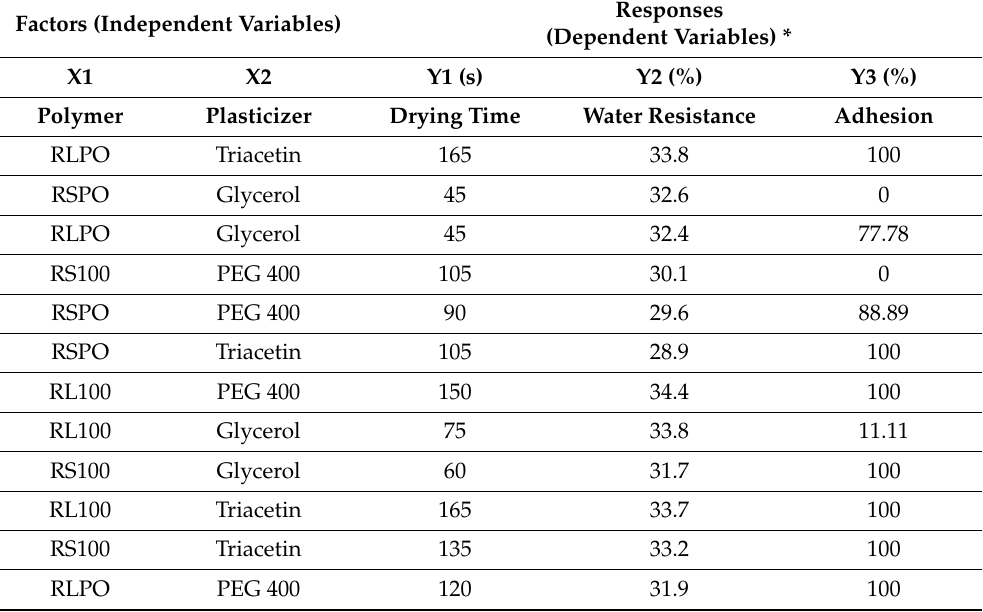
Table 5. Randomized experimental trials for the antifungal lacquer formulations with two controlled variables and three dependent responses for the selection of the types of polymer and plasticizer. Responses Factors (Independent Variables) (Dependent Variables) * X1 Y3 (%) Polymer Plasticizer Drying Time Water Resistance